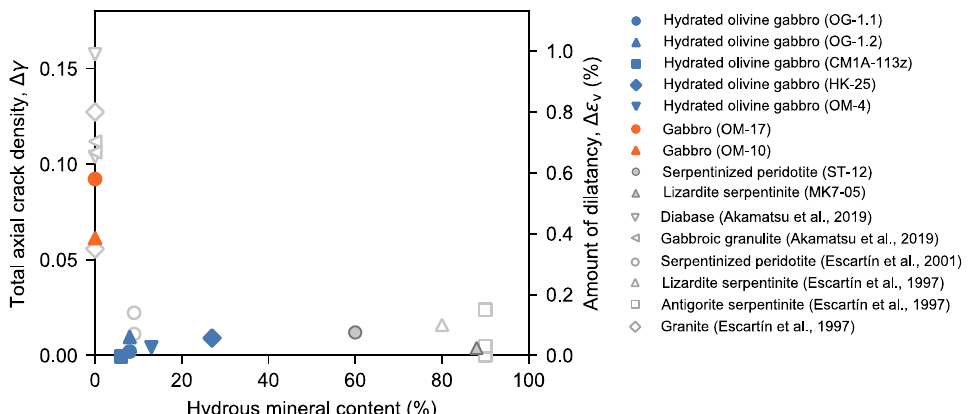
Figure 8. Relationship between the total axial crack density, amount of dilatancy, and hydrous mineral content for each experimental sample. The total axial crack density was calculated using the effective medium theory [4,27]. The amount of dilatancy was calculated as ∆ ε v = ∆ φ c = 2 π ∆ γα , using an aspect ratio of 0.01. Moreover, plotted are experimental data for a range of dilatant and non-dilatant rocks reported by previous studies [2,6,36]. Experimental conditions were 20 MPa and room temperature for data from Akamatsu et al. [36] and 50–200 MPa and room temperature for data from Escartín et al. [2,6].